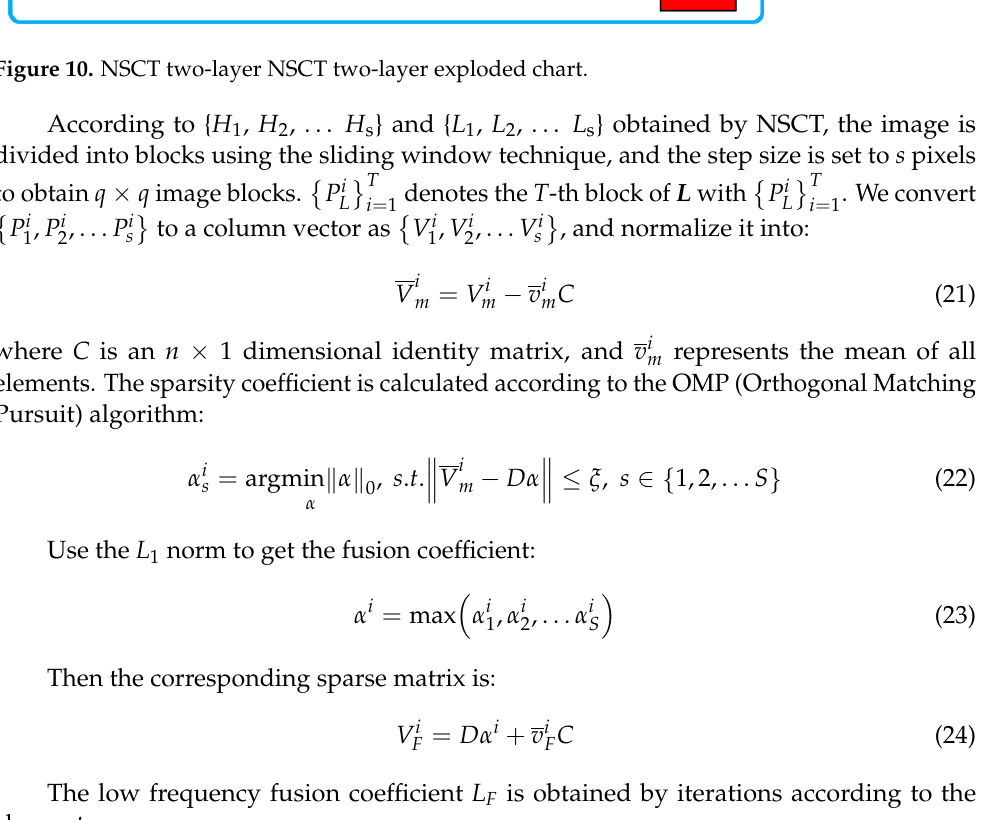
(cid:9) T (cid:8) P i . We convert L i = 1